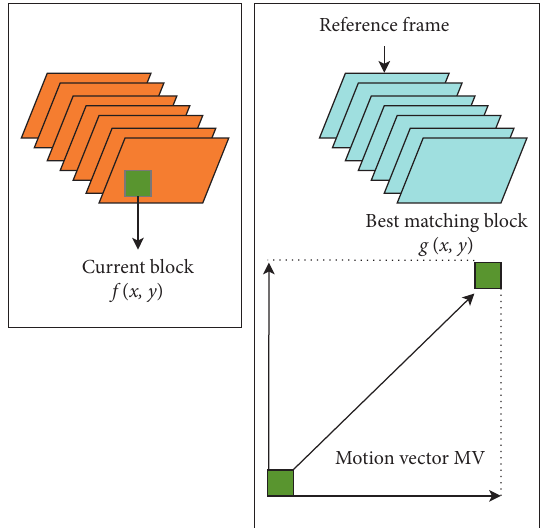
Figure 9: Schematic diagram of block matching